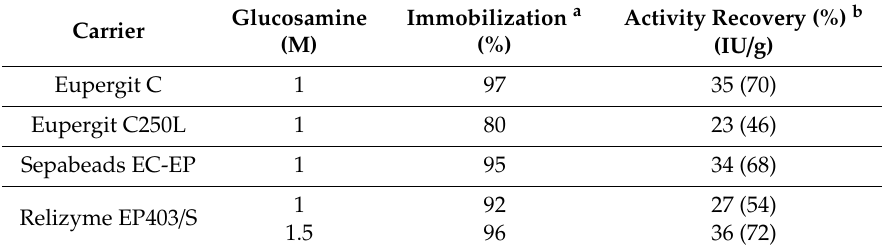
Table 1. Immobilization on epoxy-carriers coated with